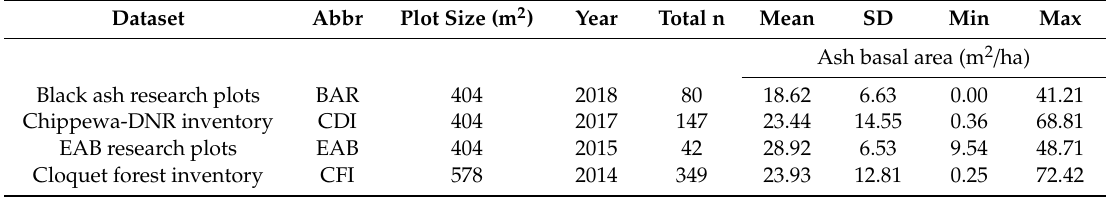
Figure 3. Location of forest inventory plots with county boundaries from a variety of county, state, and research plots used to train a spatial predictive model of ash basal area in Minnesota, USA, including inventory plots from Chippewa-Department of Natural Resources (CDI), black ash research (BAR), emerald ash borer research (EAB), and Cloquet Forestry Center plots (CFI). Insets show (1) CDI systematic sample plots, (2) CFI inventory plots, (3) raster resolution view of the CDI inventory plots. Table 2. Forest inventory plot measurements used to train a spatial predictive model of ash basal area based on imputation of lidar derived canopy height model metrics in Minnesota,